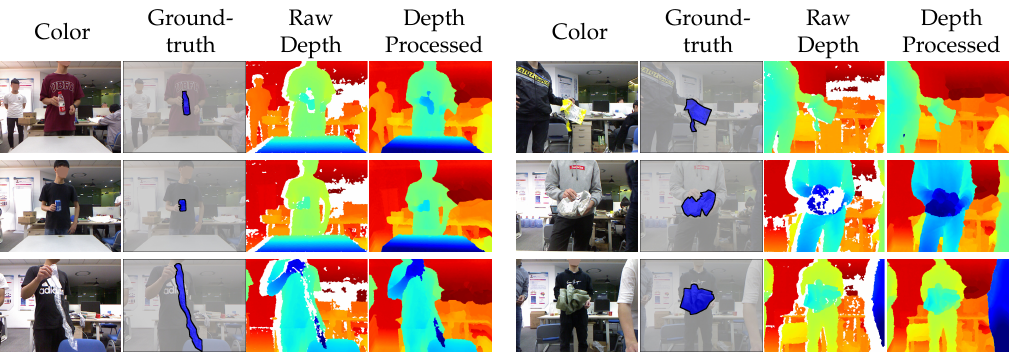
Figure 5. Example color frames, ground-truth annotations, and depth frames from the MJU-Waste dataset. Ground-truth masks are shown in blue. Missing values in the raw depth frames are shown in white. These values are filled in with a median filter following